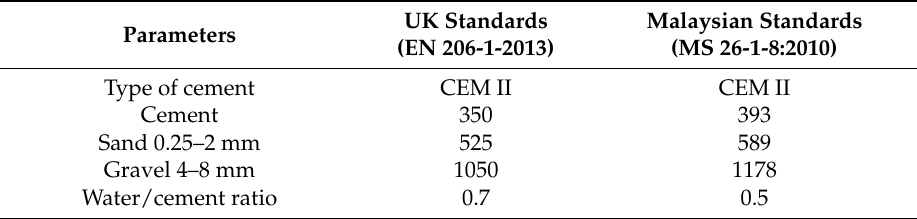
Table 2. Concrete composition with OPC (CEM II 32.5 R)- kg/m 3